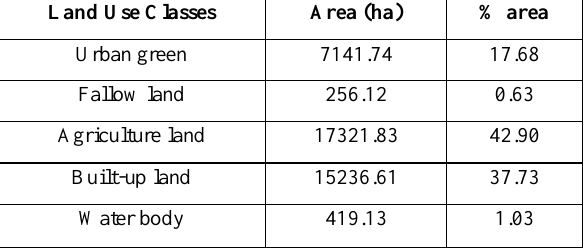
Table 2: Land Use/ Land Cover 2015